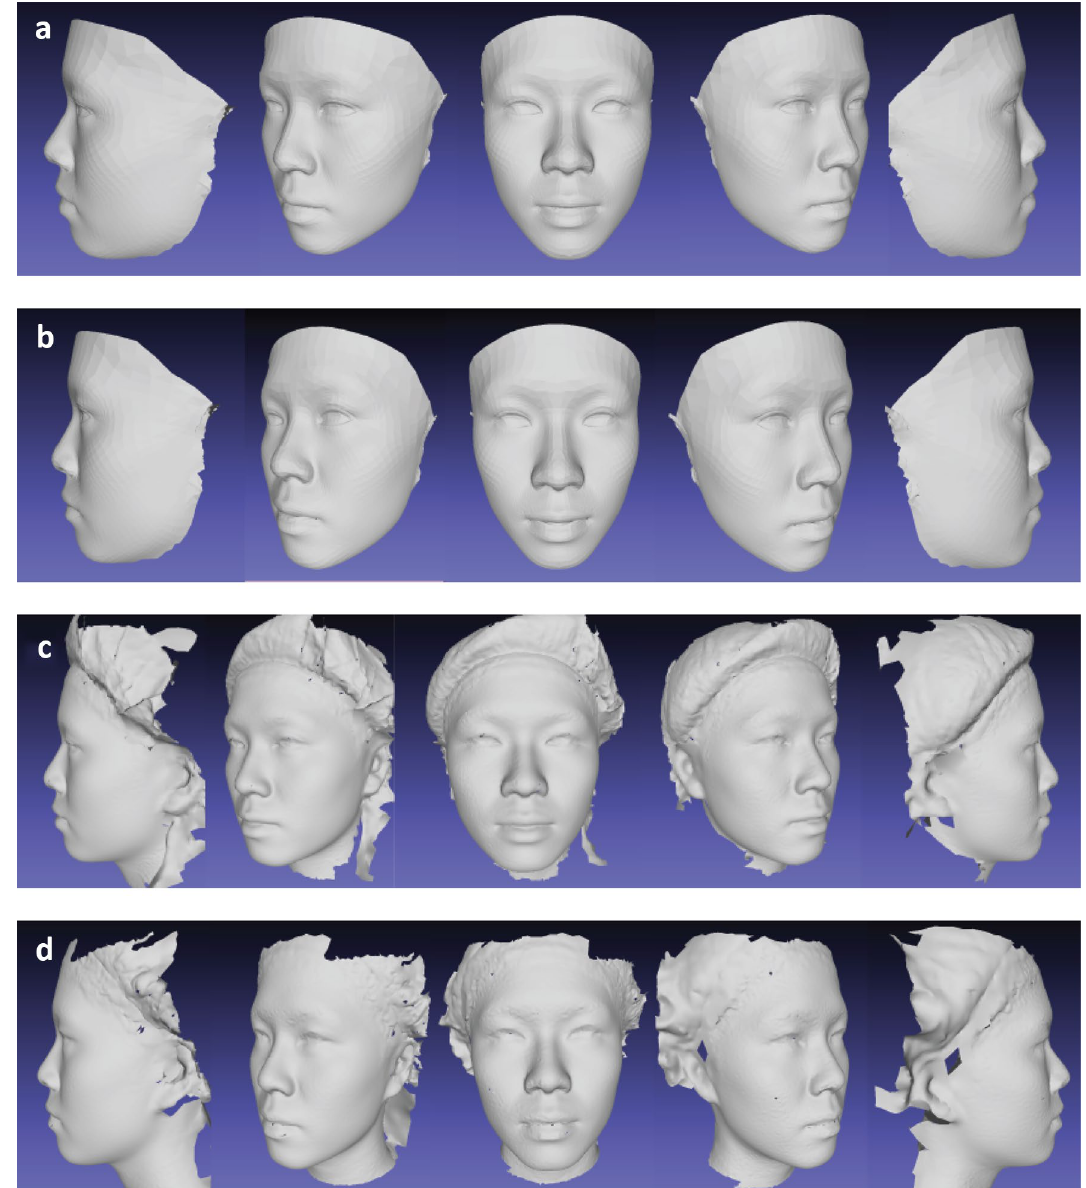
Figure 3. Average faces of 26 subjects generated by MorphAnalyser with two sets of landmarks on one randomly-selected original image and the generic mesh respectively. ( a) Ave_MG15, ( b) Ave_MG24, ( c) Ave_ MO15, ( d)